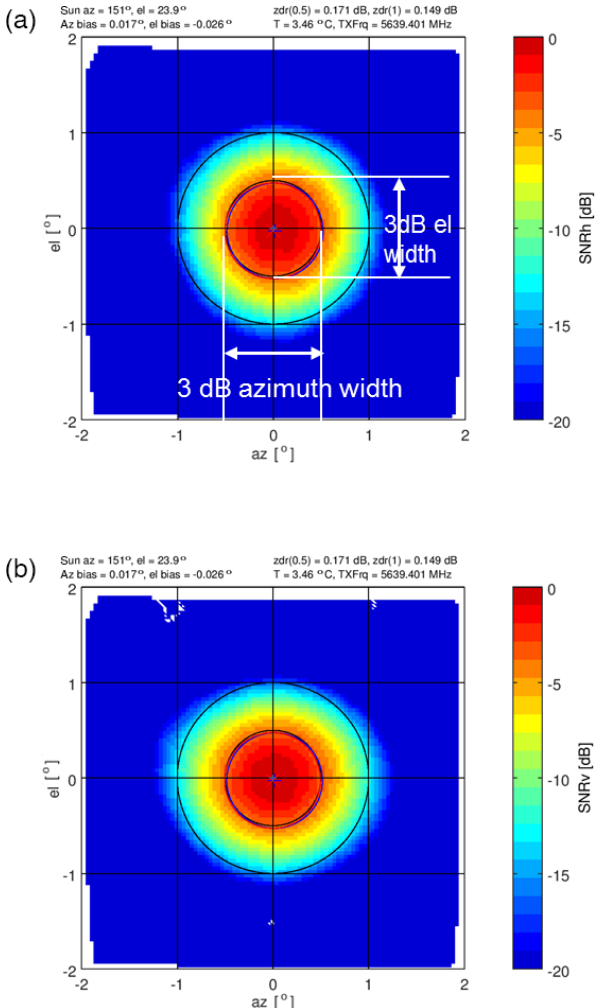
Figure 2. Typical SNR solar beam plot from a box scan, show- ing SNRh (a) and SNRv (b) . These plots illustrate how the solar beamwidths are computed. On top of each panel, the corresponding position of the sun relative to the radar, the computed elevation (el) and azimuth (az) radar positioning bias, the transmit frequency, the radome temperature, and the Z DR integrated over 0.5 and 1 ◦ radii is given as a standard information data set with this product. The red and blue crosses indicate the azimuth and elevation bias for the two